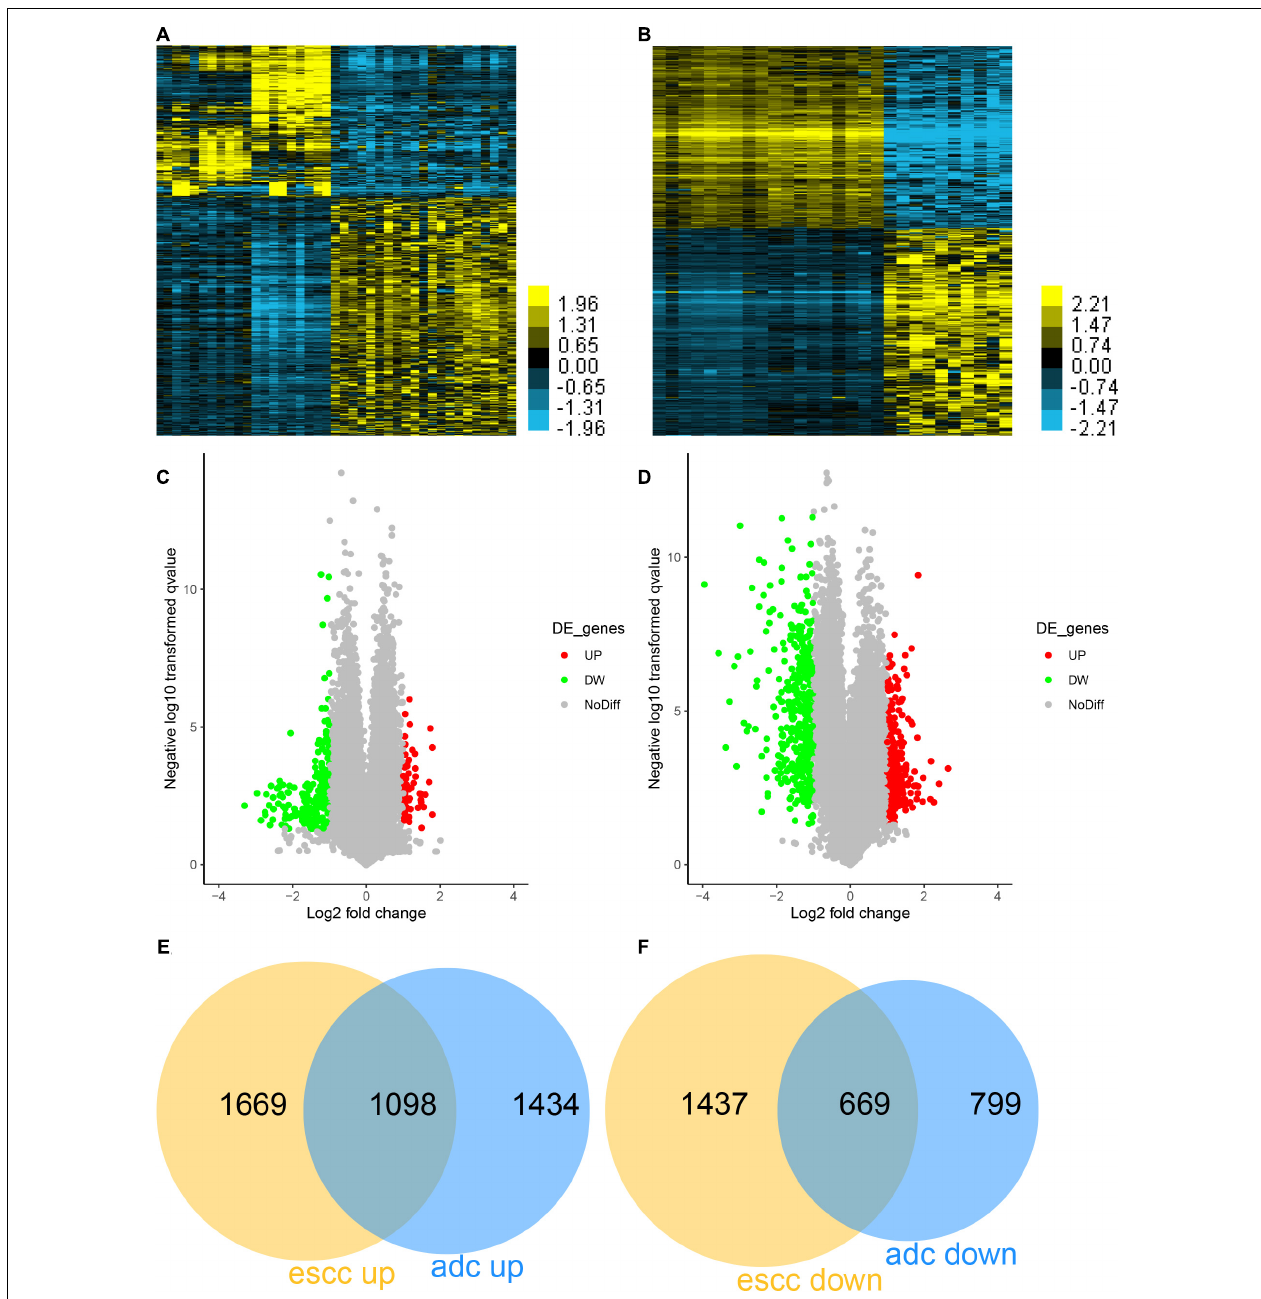
FIGURE 1 | Identification of differentially expressed genes (DEGs) in esophageal adenocarcinoma (EA) and esophageal squamous cell carcinoma (ESCC). (A) The differently expressed genes between EA and Barrett’s esophagus samples were shown using Heatmap. (B) The differently expressed genes between ESCC and esophageal squamous epithelium samples were shown using Heatmap. (C) The differently expressed genes between EA and Barrett’s esophagus samples were shown using Volcano Plot. (D) The differently expressed genes between ESCC and esophageal squamous epithelium samples were shown using Volcano Plot. (E) The common upregulated genes in both EA and ESCC were determined using Venn diagram. (F) The common downregulated genes in both EA and ESCC were determined using Venn diagram.